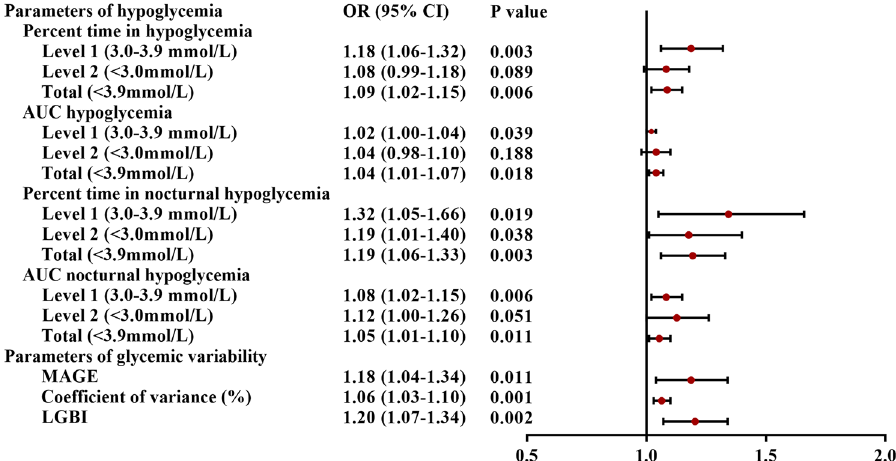
Figure 2. Odds ratios and 95% confidence intervals comparing the risk of CGM parameters for subjects with and without